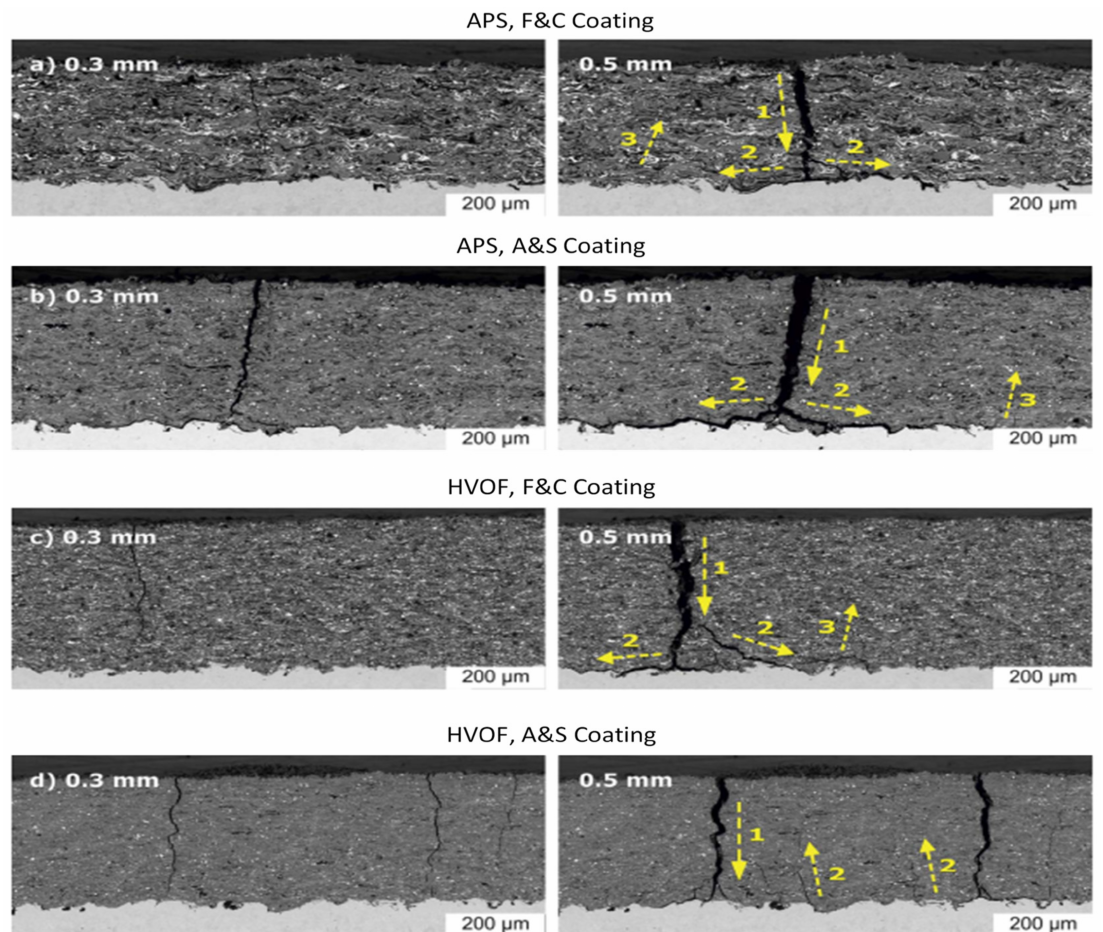
Figure 20. Fracture progression during in situ three-point bending of APS ( a ) F&C, ( b ) A&S; and HVOF ( c ) F&C, ( d ) A&S coatings. Displacement of the central support 0.3 mm ( left ) and 0.5 mm ( right ). Cracking direction and propagation are represented by the yellow arrows